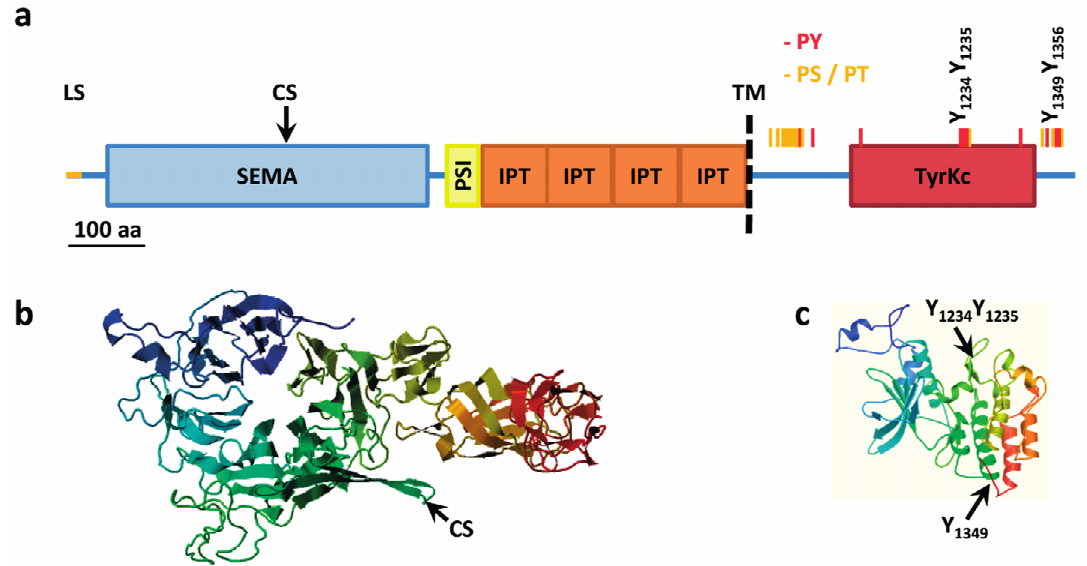
Figure 1. MET structure. ( a ) MET structural domains. MET domains as predicted